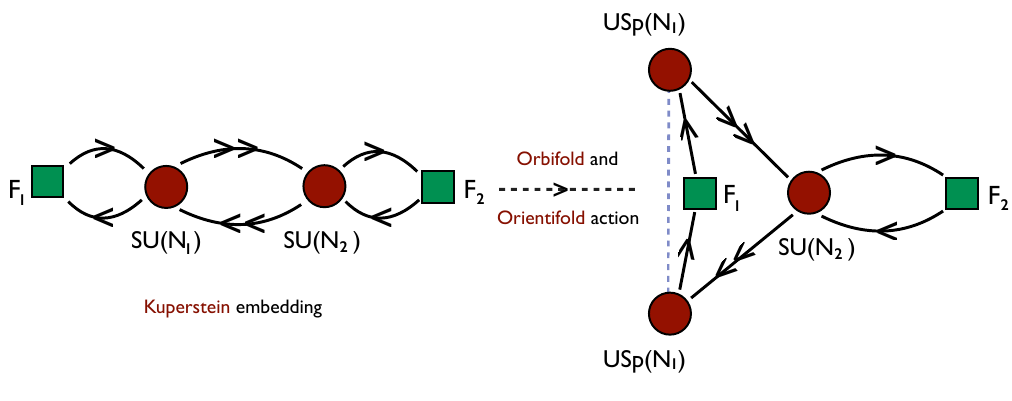
Figure 5 . The conifold and the F 0 = (cid:10) theories with (Kuperstein-like)